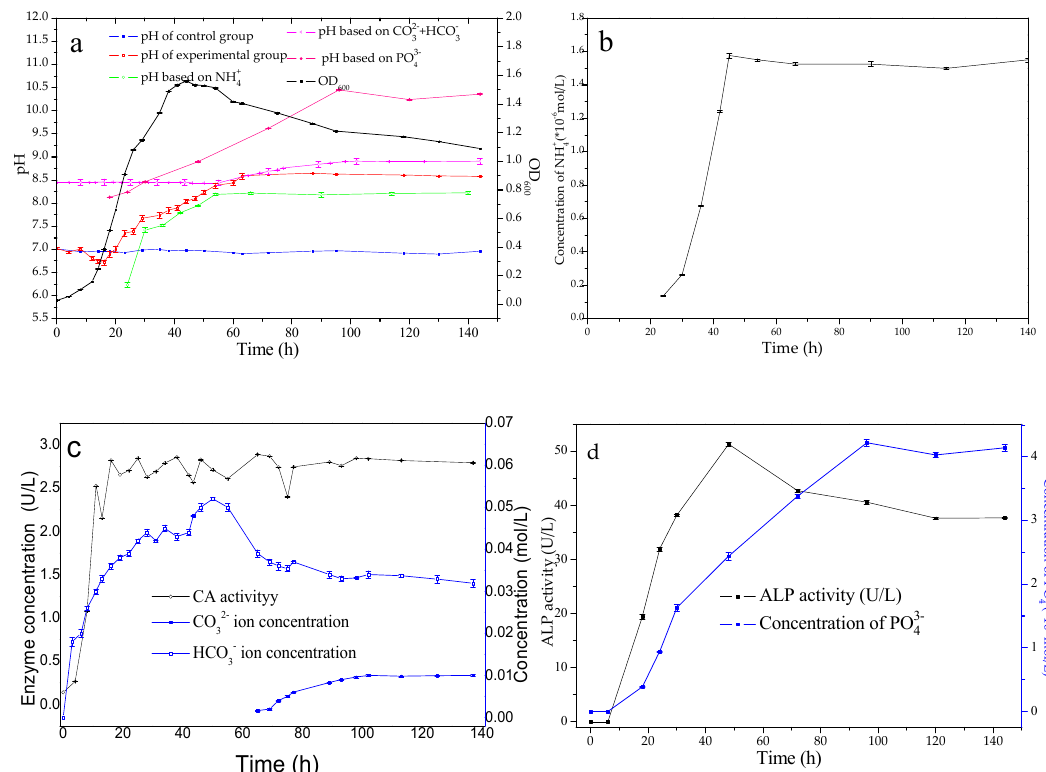
Figure 1. Biochemical characteristics of S. warneri YXY2 bacteria. ( a ), growth curve and pH curves; ( b ), NH 4 + concentration; ( c ), CA activity and the concentration of CO 32 − and HCO 3 − ; ( d ), ALP activity and the concentration of PO 3 4 − .